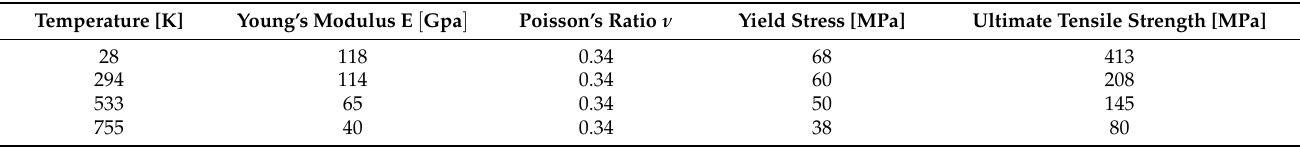
Table 5. Mechanical properties of the electrodeposited OFHC Cu.